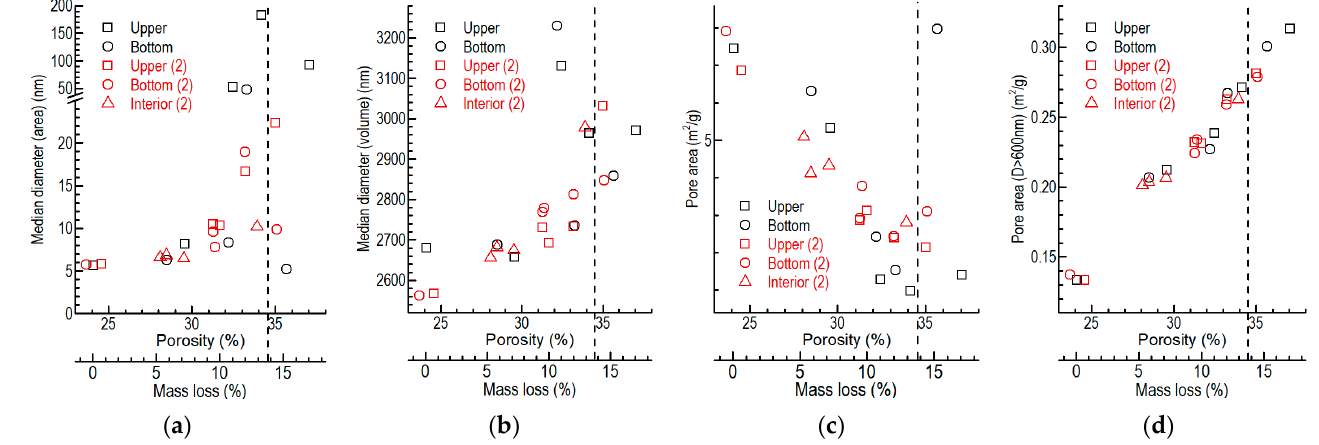
Figure 13. Diameter and pore area versus the porosity and mass loss of the specimen: ( a ) median diameter (area); ( b ) median diameter (volume); ( c ) pore area; ( d ) pore area (D > 600 nm).